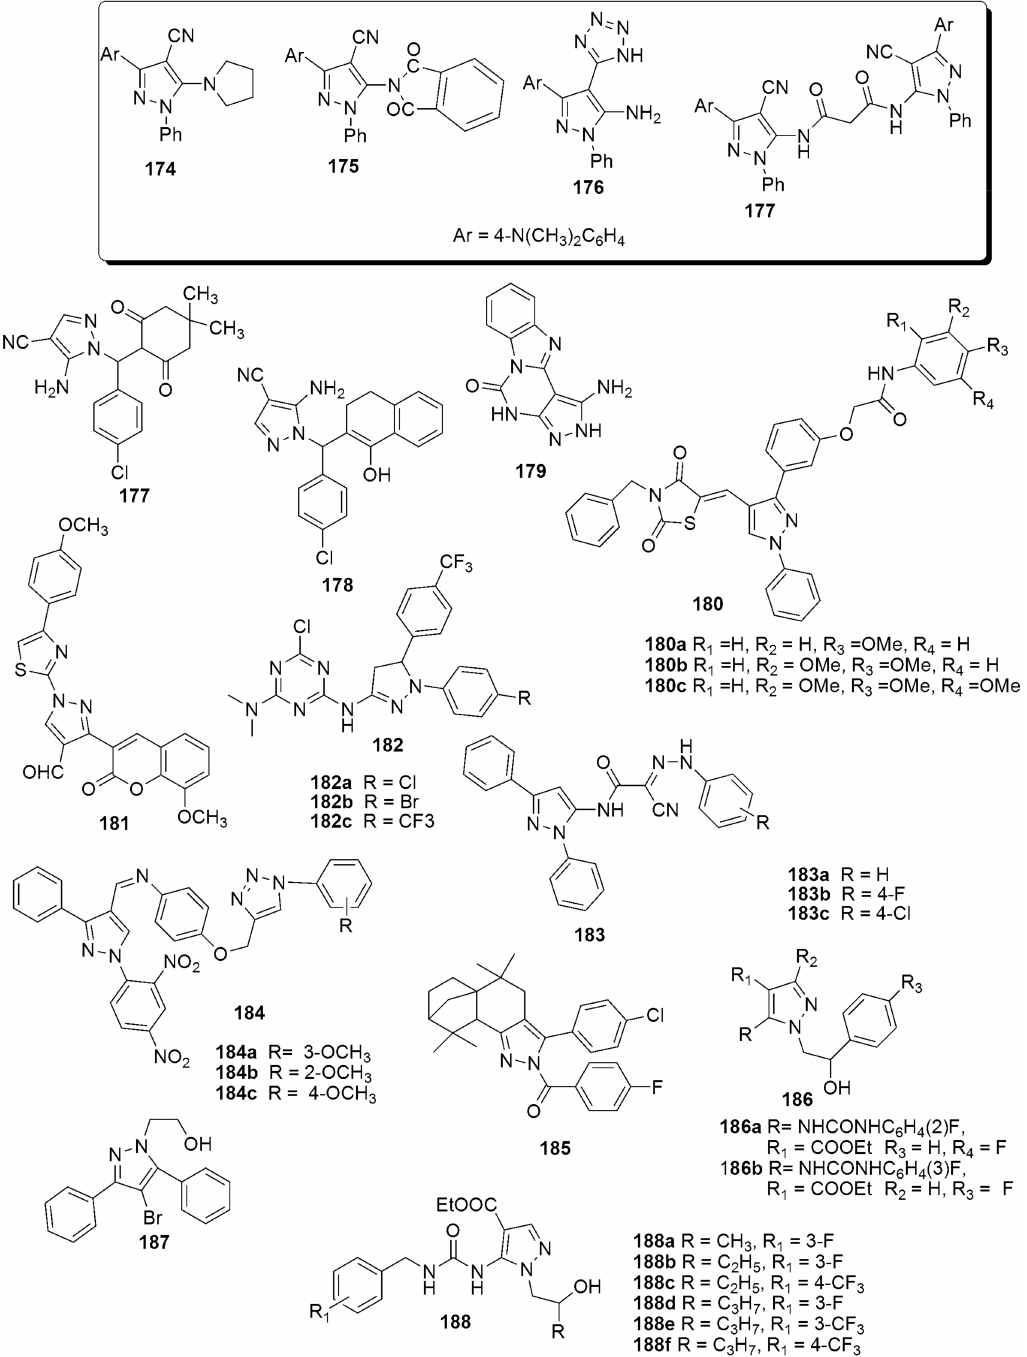
Figure 8. Structures of pyrazole derivatives acting as anticancer